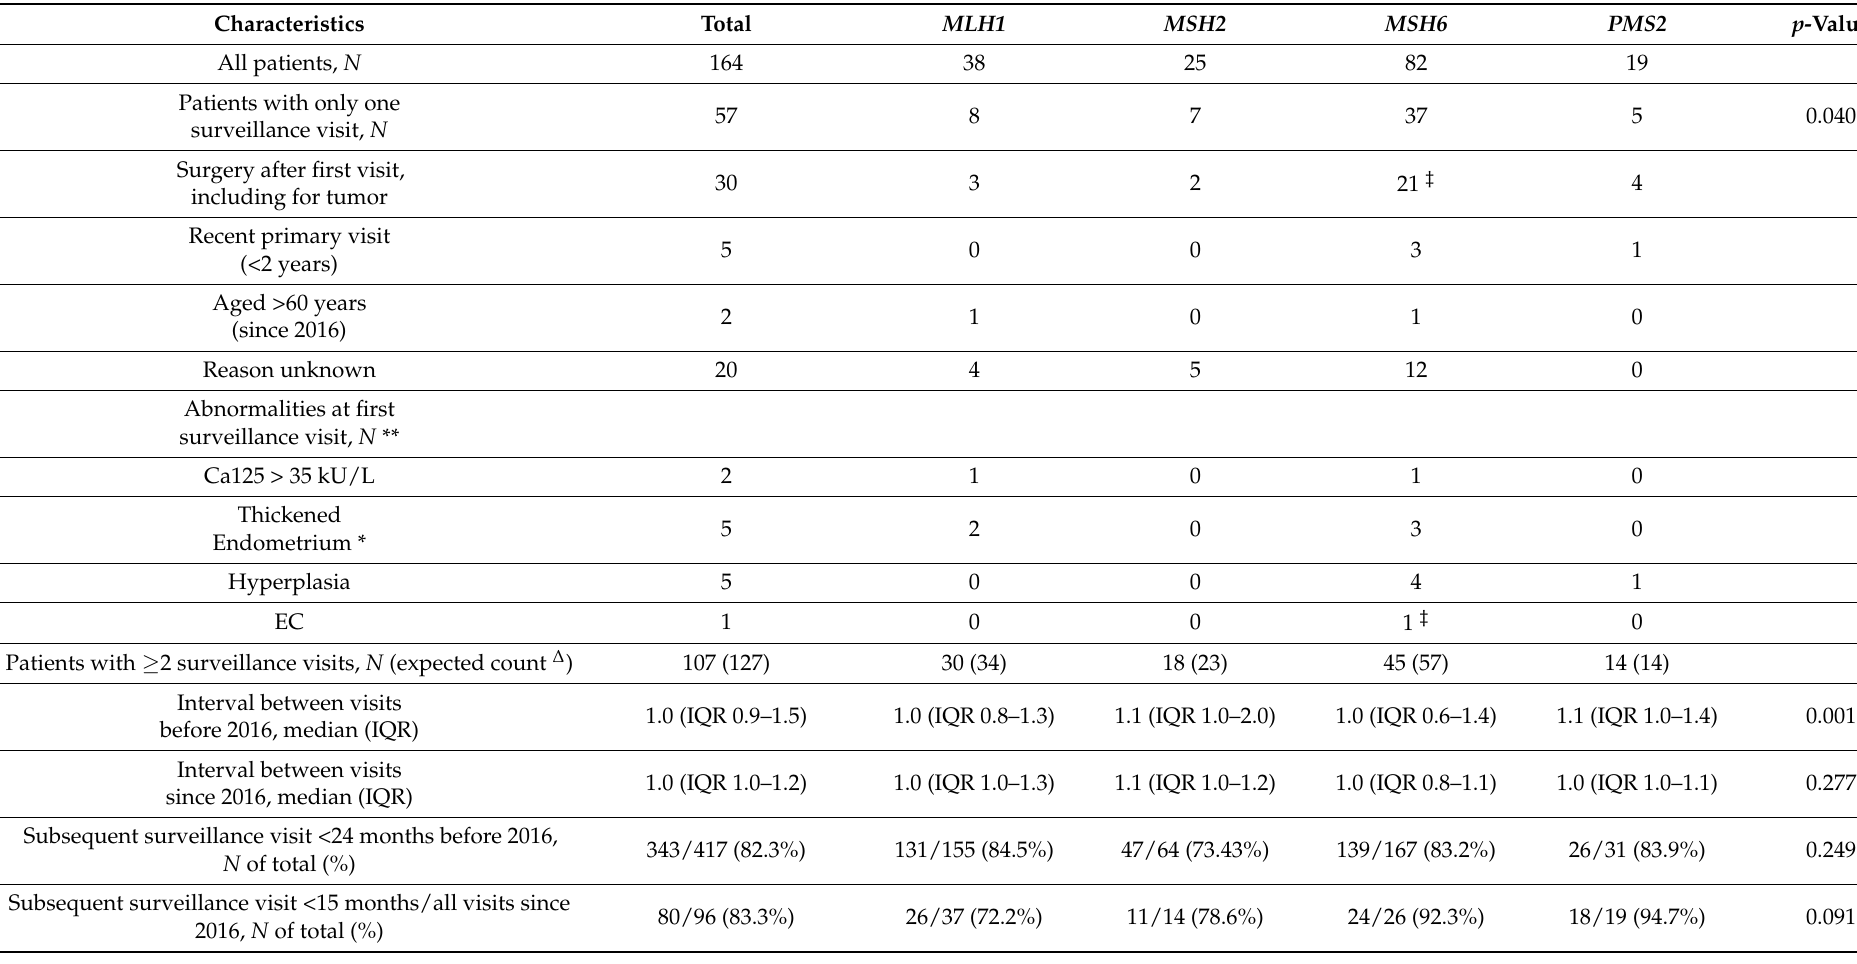
Table 2. Characteristics of gynecological surveillance